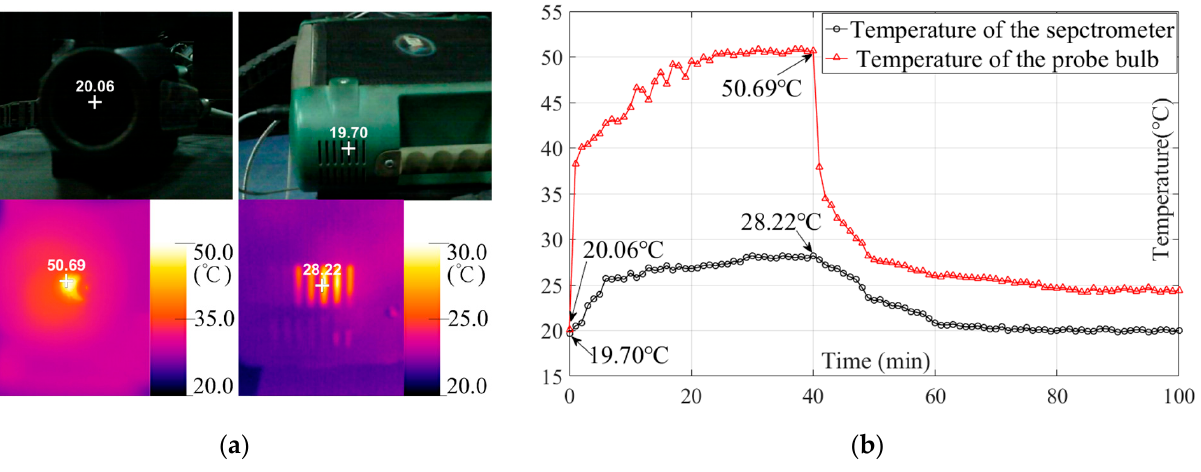
Figure 13. ( a ) Temperature measurement of the spectrometer and the bulb in the probe; ( b ) temperature variation during the working period.